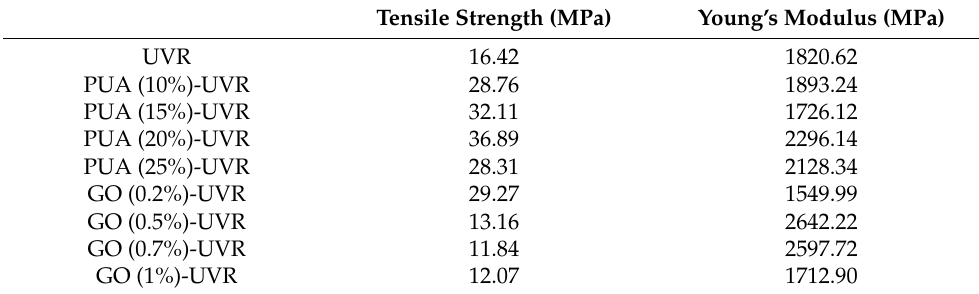
Table 6. Tensile strength and Young’s modulus of the unmodified and modified hybrid resins.